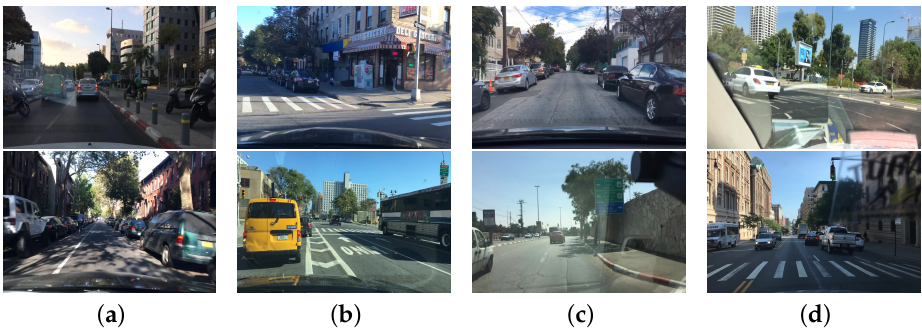
Figure 11. Traffic scene images of BDD100K data set, where ( a – d ) are images of traffic captured in different street